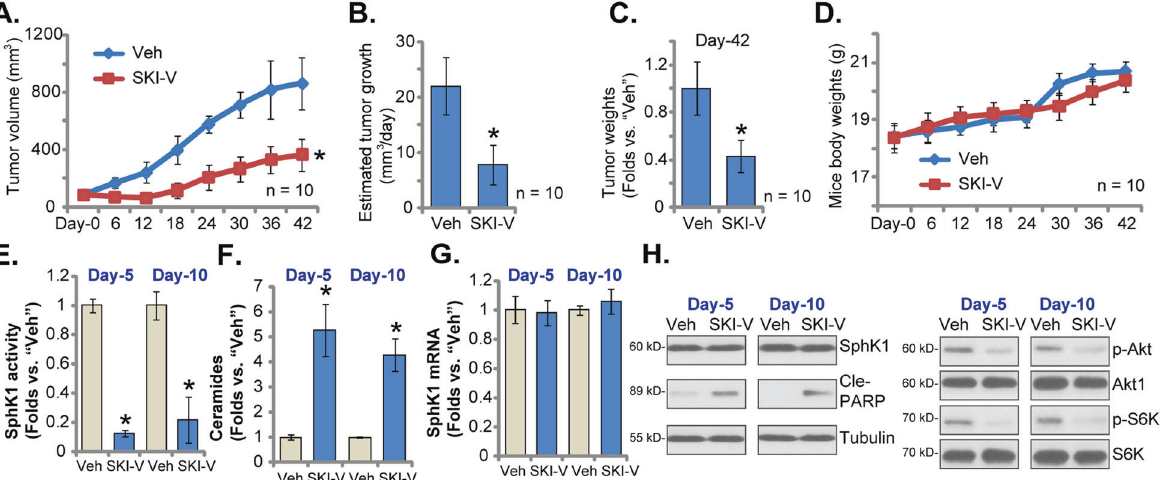
Fig. 6 The anti-OS cell activity of SKI-V in vivo. The “ C1 ” OS xenograft-bearing nude mice were subject to intraperitoneal ( i.p .) injection of SKI-V (30 mg/kg body weight, daily for 18 days) or vehicle control ( “ Veh ” ), with ten mice per group. Tumor volumes ( A ) and mice body weights ( D ) were recorded every six days (from Day-0 to Day-36). The estimated daily tumor growth, in mm 3 per day, was calculated ( B ). At Day-36, all mice were anaesthetized and decapitated, OS xenografts were weighted ( C ). At experimental Day-5 and Day-10, one tumor of each group was isolated (total for tumors), the relative SphK1 activity ( E ), ceramide contents ( F ), and expression of SphK1 mRNA ( G ) and listed proteins ( H ) were shown. Data were presented as mean ± standard deviation (SD). * P < 0.05 vs. “ Veh ” group.